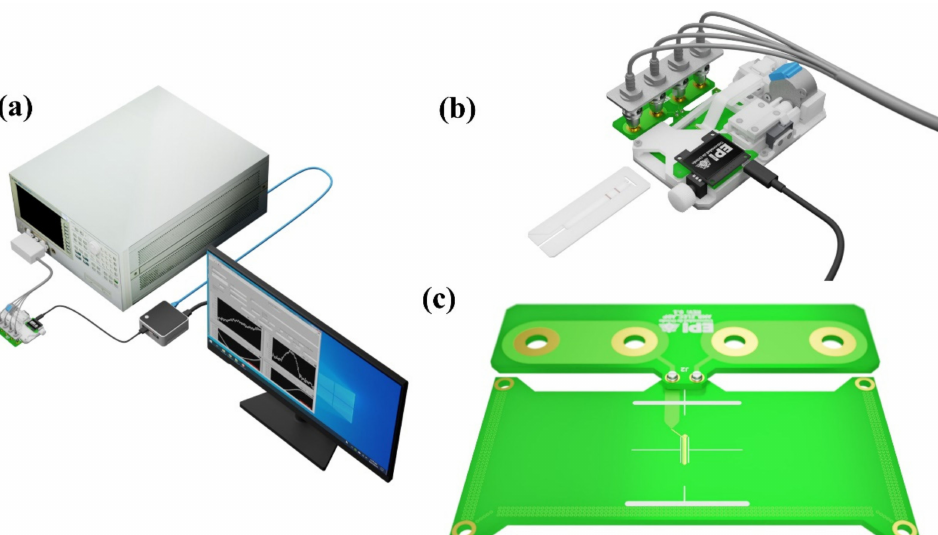
Figure 1. ( a ) Schematic representation of the sensing system showing the impedance analyzer, the micropositioner, and the personal computer used to control both. ( b ) Image of the sensing device, which comprises the planar inductor, the LFAs holder containing an LFA sample, and the micropositioner. The image is represented to scale. ( c ) Detailed image of the planar inductor specifically designed to encompass the entire width of the LFAs during